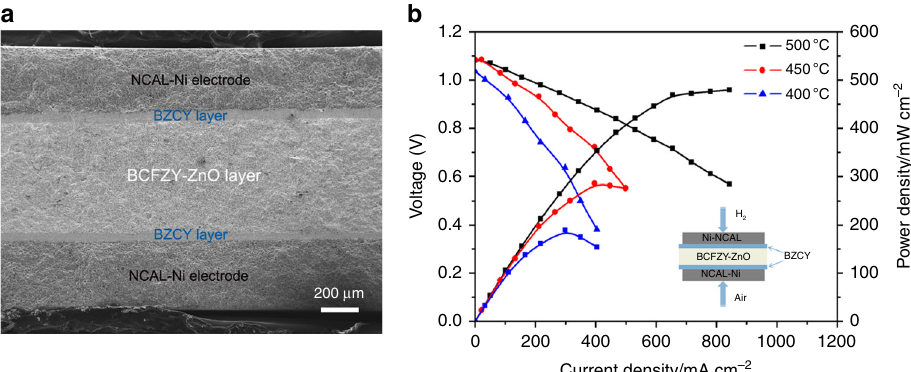
Fig. 3 Hybrid H + /O 2- conduction ( a ) A cross-sectional SEM image of the O 2- /e - blocking cell in con fi guration of NCAL-Ni/BCZY/BZFCY-ZnO/BCZY/ NCAL-Ni, ( b ) I – V characteristics of the cell measured at 400 –